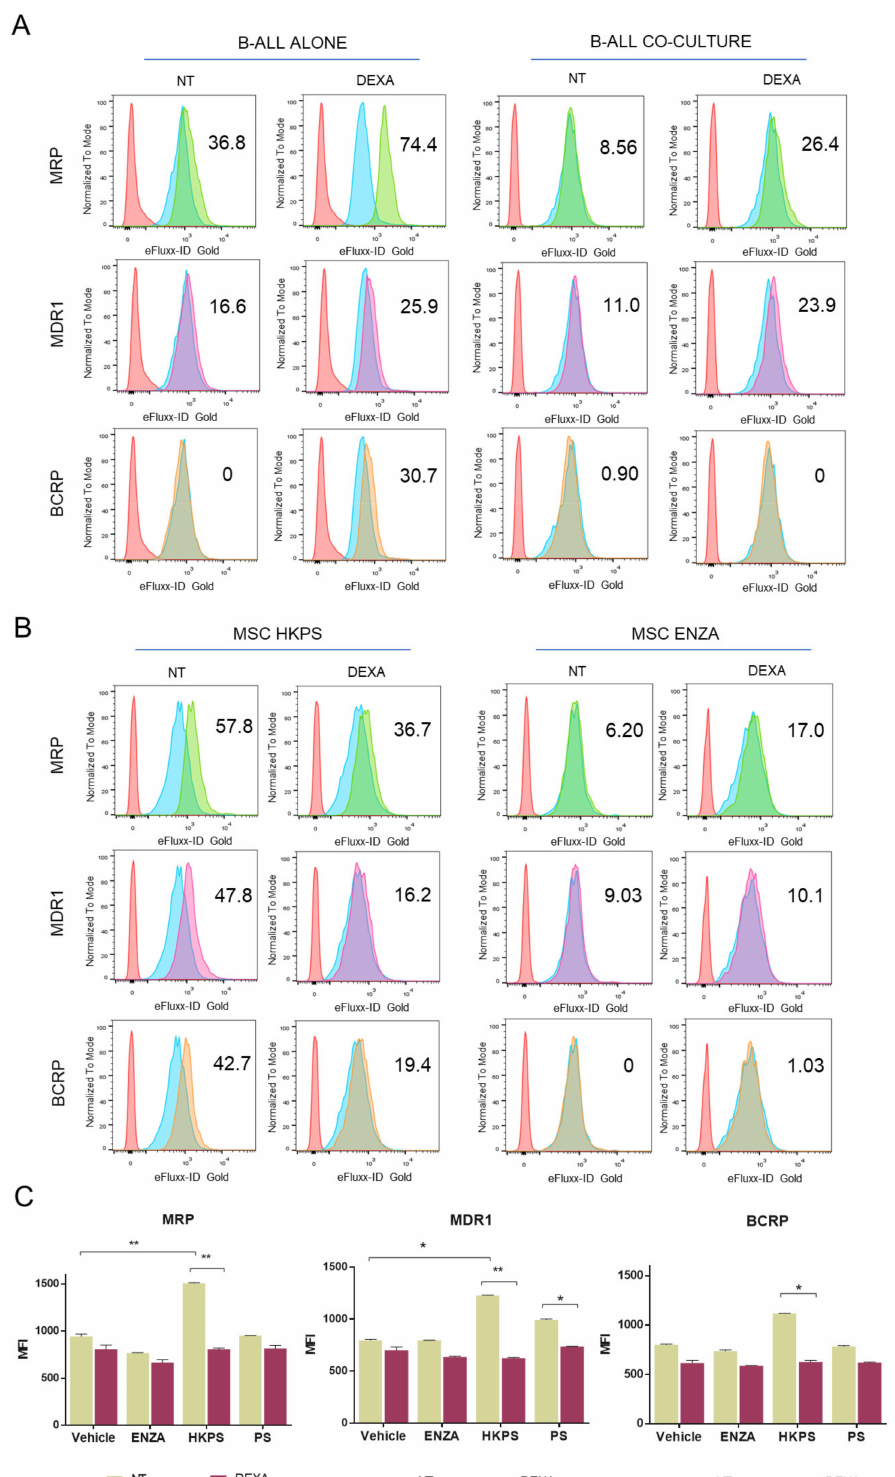
Figure 6. The co-culture with MSC induces changes in ABC transporters’ activity in B-ALL cells, and PKC inhibition with HKPS increases this effect. ( A ) Influence of the mesenchymal support on MDR1, MRP, and BCRP activity in leukemic cells. Co-cultures were treated with 250 nM of DEXA for 72 h, then both MSC and adherent B-ALL cells were incubated with specific inhibitors for each